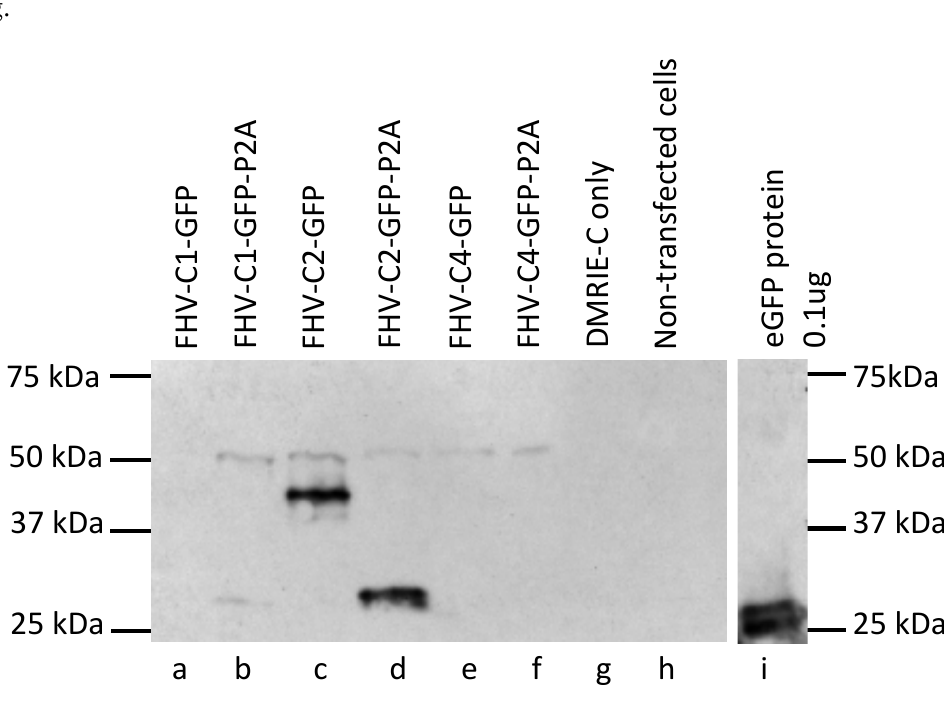
Figure 4. Western blot analysis demonstrating P2A cleavage efficiency in BHK-21 cells